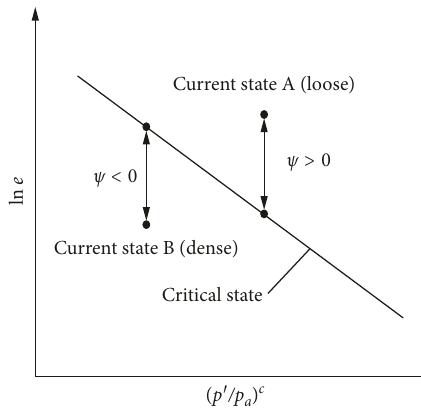
Figure 1: Definition of the state